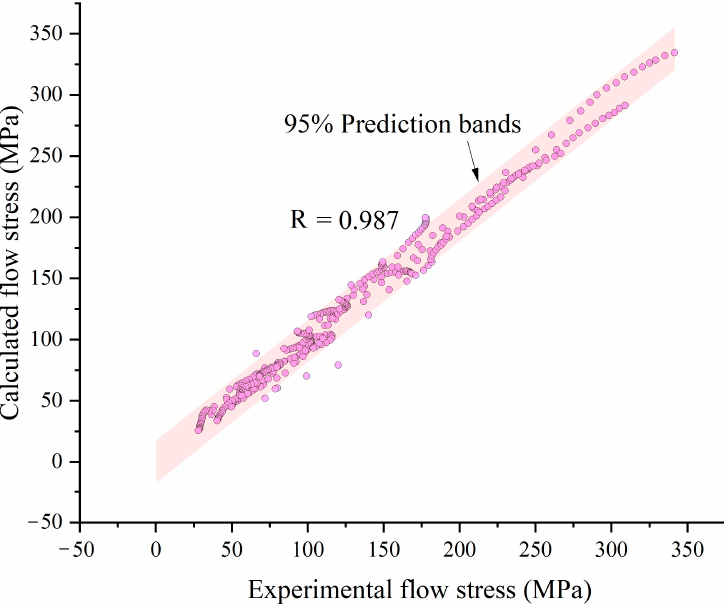
Figure 10. Scatter plots of the calculated flow stress versus experimental flow stress.